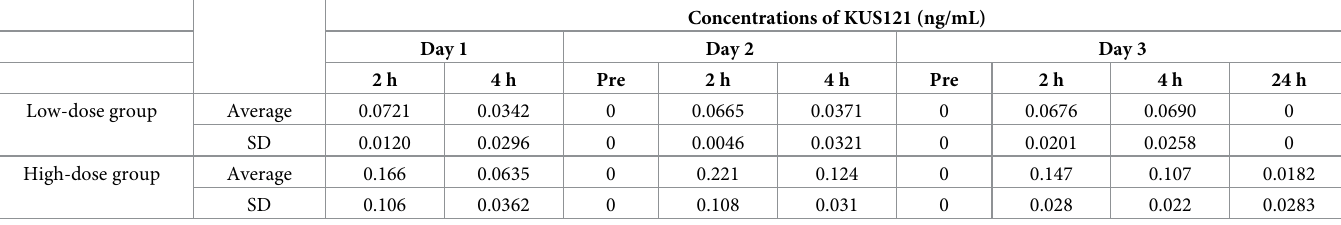
BCVA, measured using the ETDRS chart, improved during the observation period (Table 6 and Fig 2); logMAR BCVA at week 12 was improved ( > 0.3) compared with that at baseline in all nine patients. The change in logMAR BCVA from baseline to week 12 was -1.65 ± 0.47 for the low-dose group and -0.92 ± 0.57 for the high-dose group (Table 6 and Fig 2A and 2B). The number of readable ETDRS letters at week 12 were also increased compared with that at base- line (Table 6 and Fig 2C and 2D). The change in ETDRS letter counts (week 12 vs. baseline) was 42.0 ± 40.0 letters in the low-dose group and 25.7 ± 23.7 letters in the high-dose group. At week 12, the proportion of patients with decimal BCVA equal to or better than 0.02 (log- MAR 1.70 equivalent) was 100% (3/3) for the low-dose group and 83.3% (5/6) for the high- dose group (89% for all). Similarly, the proportion of patients with decimal BCVA equal to or better than 0.05 (logMAR 1.30 equivalent) was 66.7% (2/3) and 83.3% (5/6), respectively, and that of patients with decimal BCVA better than 0.1 (logMAR 1.00 equivalent) was 66.7% (2/3) and 33.3% (2/6), respectively (44% overall, Table 7). The patients’ visual fields, measured using Goldmann perimetry, enlarged after the treat- ment. The average area of V4e isopter at week 12 was 105.1 ± 71.0 cm 2 for the low-dose group and 90.3 ± 70.6 cm 2 for the high-dose group, which had increased from 36.7 ± 14.9 cm 2 and 76.0 ± 75.8 cm 2 at baseline, respectively (Table 6, Fig 3A and 3B). Visual field and Esterman disability scores, for which the normal field rates were set at 100%, were 17.0 ± 10.1% for the low-dose group and 28.7 ± 16.0% for the high-dose group at baseline, improving to 47.0 ± 34.0% and 62.7 ± 36.1% at week 12, respectively (Fig 3C and 3D). Retinal sensitivity, measured using MP-3 microperimetry, improved at 12 weeks compared with baseline in all three areas (Table 6, Fig 3E–3G). A number of additional variables affecting visual function are summarized in S1–S5 Tables. These include the presence or absence of a patent cilioretinal artery, whether the pretreatment was received, and treatment with anti-platelet or anti-hypertensive medications prior to inclu- sion in the study. Table 4. Plasma concentrations of